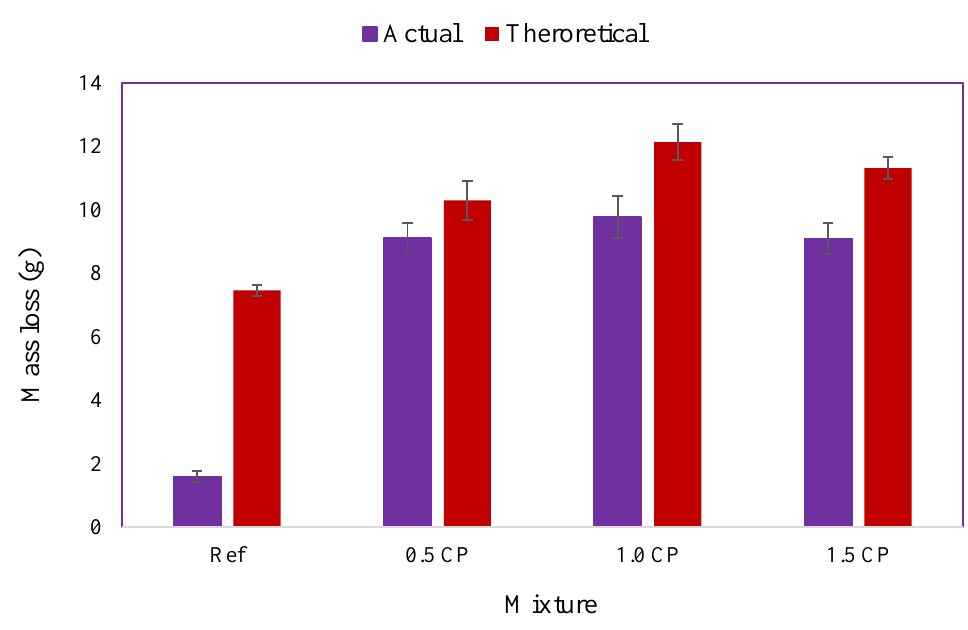
Figure 5. Reinforcement mass loss.